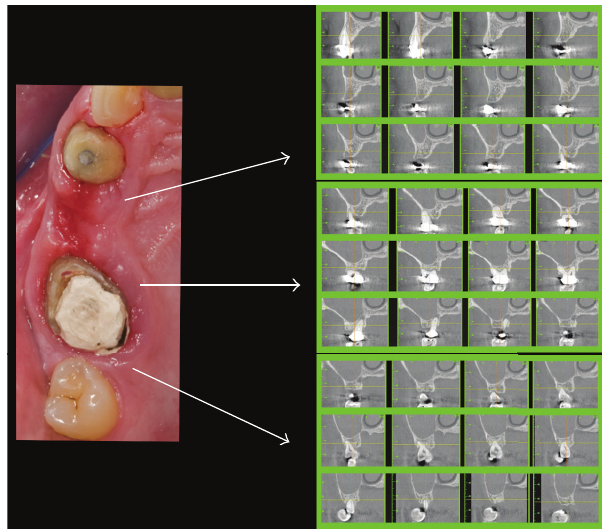
Figure 2: Clinical situation before surgery (clinical photo and TC